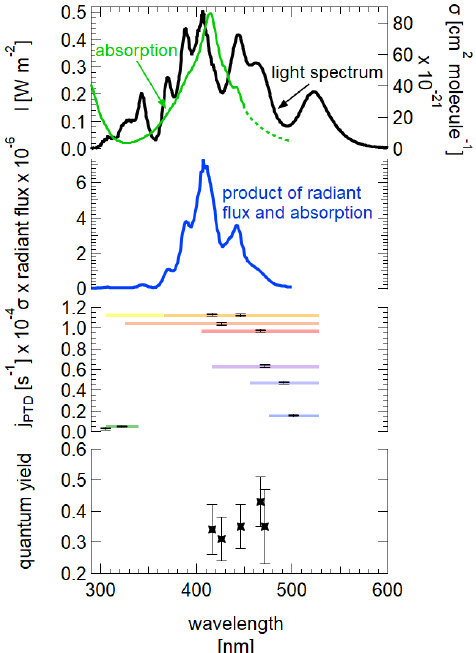
Figure 8. Top: measured spectrum of the light source at 3m height inside the chamber. Absorption spectrum of 2,3-pentanedione, ex- trapolated for the part between 450 and 500nm (data: Szabó et al., 2011). Upper middle: product of radiant flux and absorption spec- trum. Bottom middle: observed photolysis frequencies for the corre- sponding illumination at different wavelength ranges. Bottom: cal- culated quantum yields for the corresponding wavelength